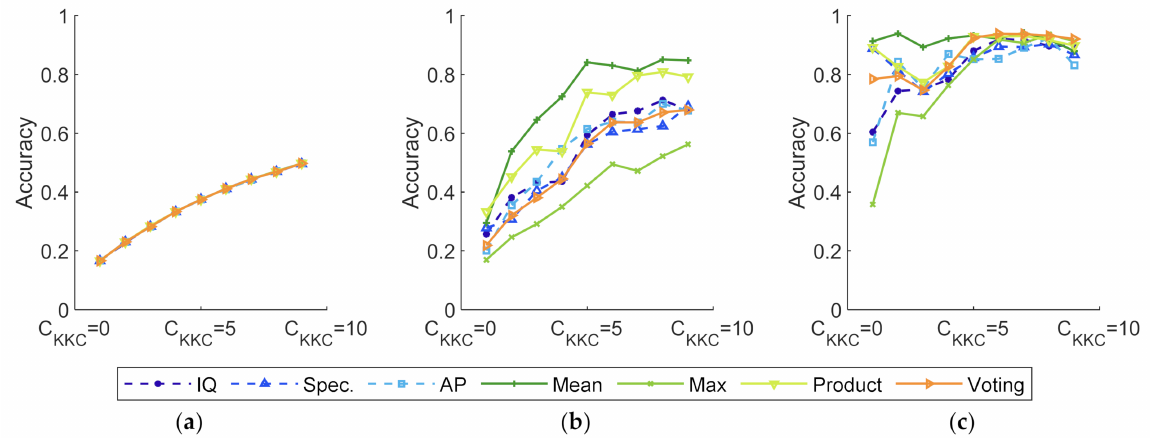
Figure 14. Accuracy of experiments with various C KKC and classifiers. ( a ) Softmax as basic classifiers; ( b ) softmax-threshold as basic classifiers; ( c ) OpenMax as basic